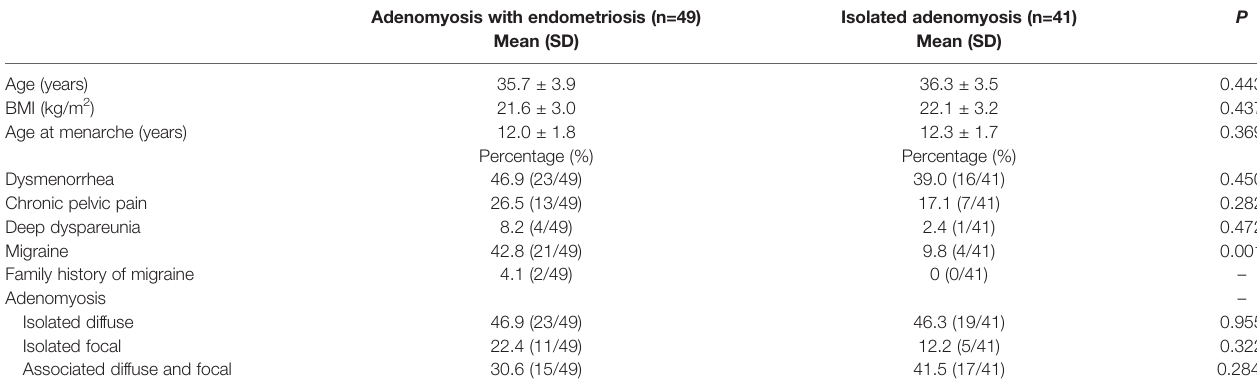
TABLE 2 | Comparison of the general characteristics of adenomyosis patients with or without